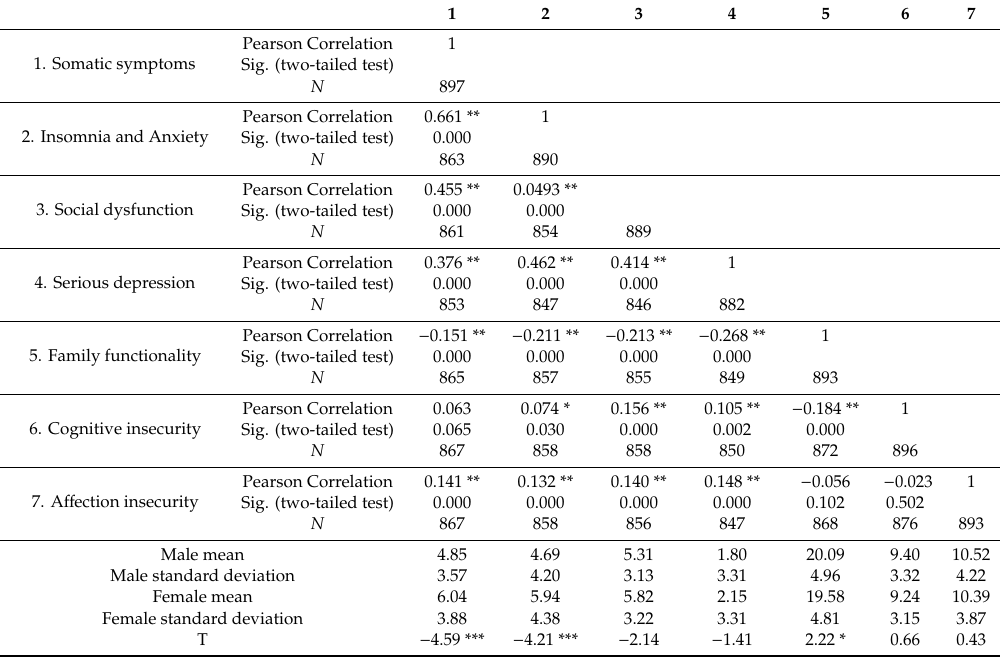
Table 1. Pearson correlations, means, standard deviation and t tests between our variables. Asterisks denote significant results: * denotes a significant correlation with a p < 0.05 (two-tailed test), ** denotes a significant correlation with a p < 0.01 (two-tailed test), *** denotes a significant correlation with a p < 0.001 (two-tailed